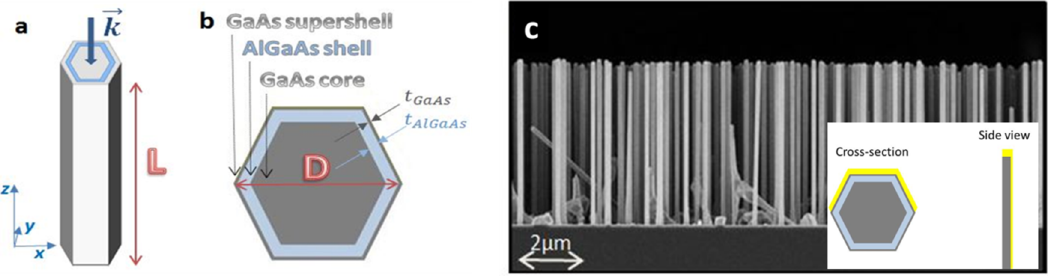
Table 1. Fabrication parameters of the nanowire (NW) samples. Data from [3].